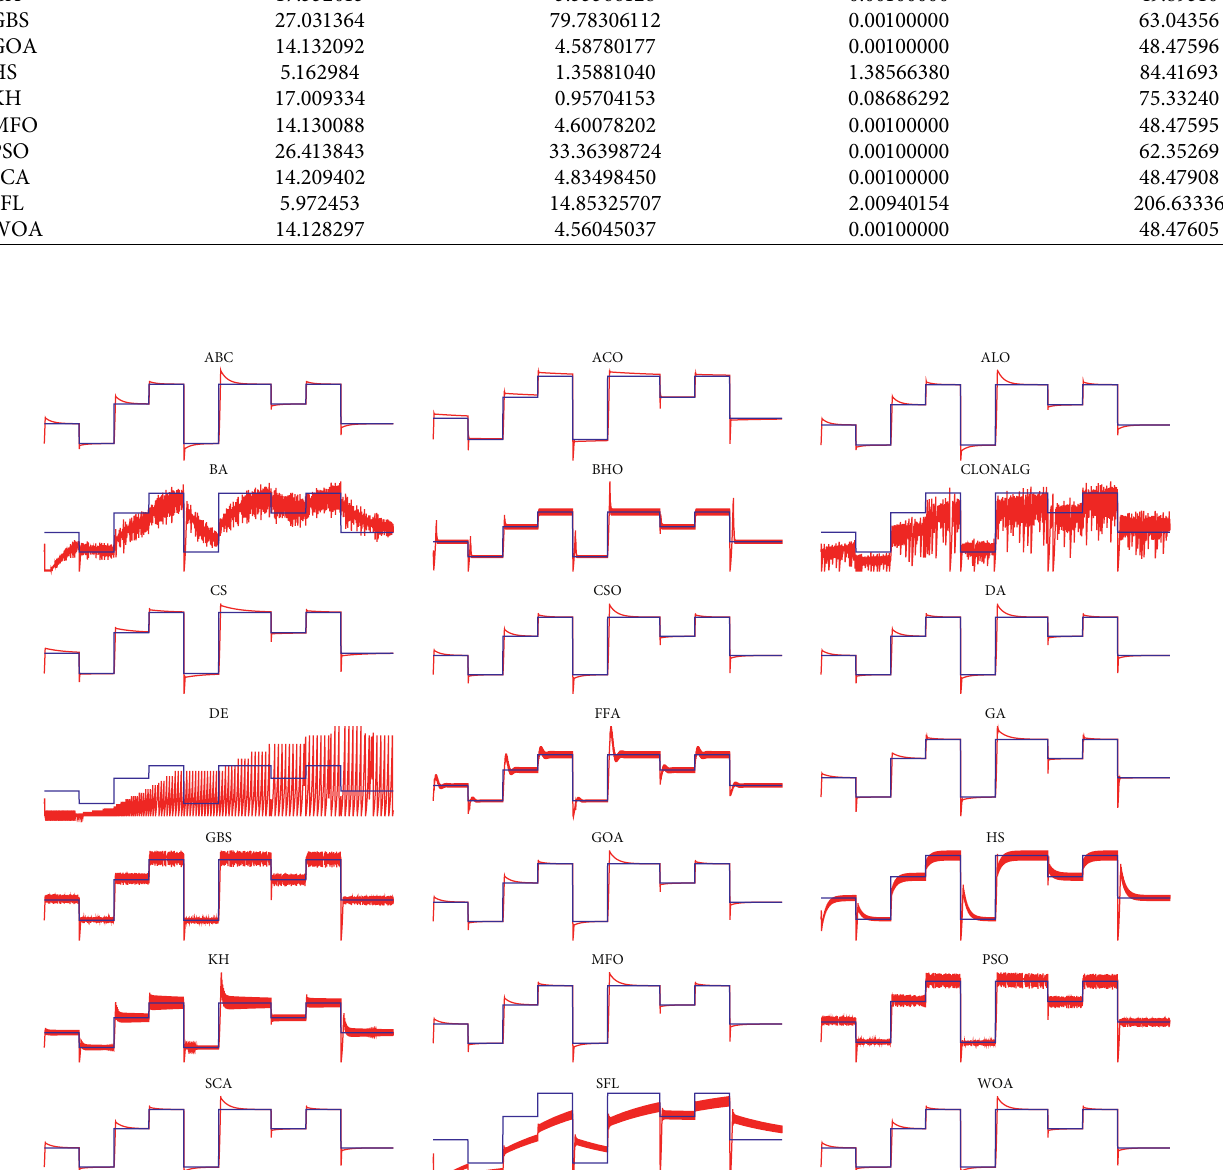
: the red line is target/ 1